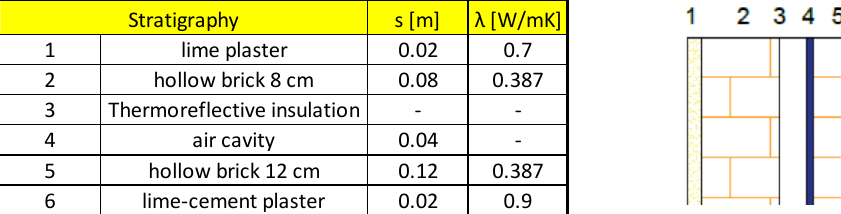
Figure A7. Wall type 3.2: stratigraphy with thicknesses and conductivities for the different layers. The numbers start from the outside. Table A4. Wall type 3.2: thermal transmittance reached with different heat-reflective materials.